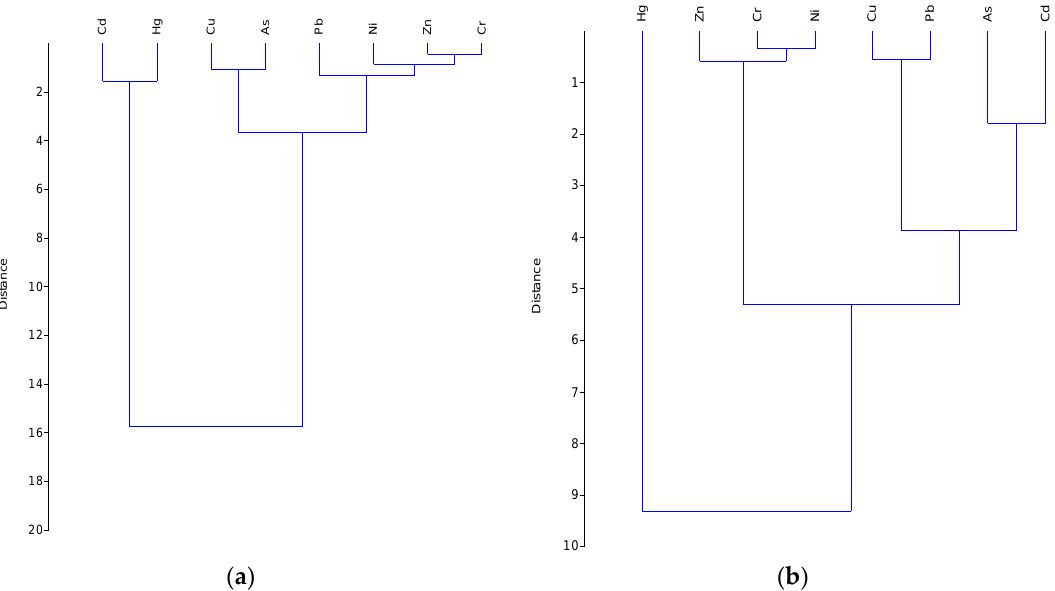
Figure 4. Dendrogram derived from the CA of analyzed concentrations of elements in Kostolac soil ( a ) and Gacko soil ( b ).